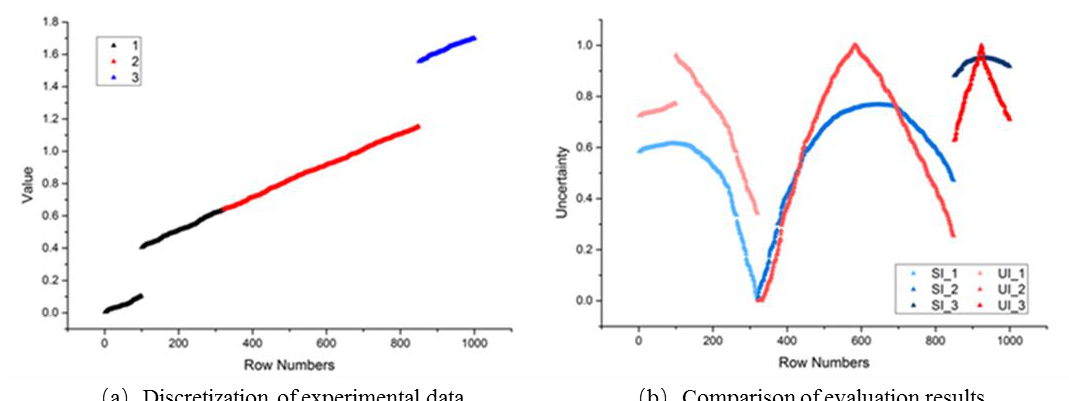
Figure 5. Verification of superiority in description of uncertainty coefficien